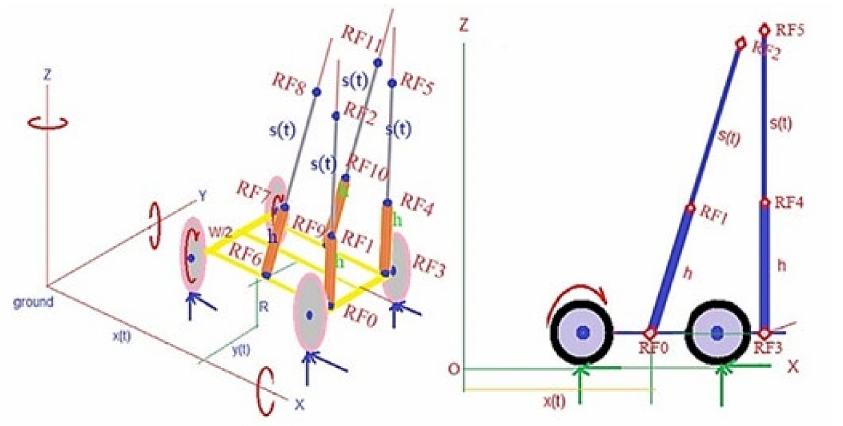
Figure 8. Schematic representation of telepresence